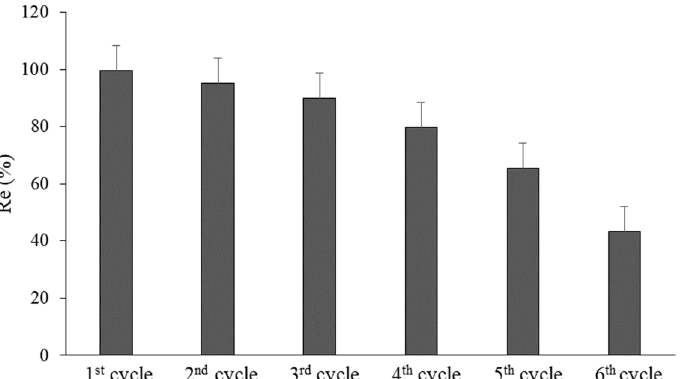
Figure 14. Pb(II) removal efficiency by nZVFe–RSAC after six consecutive cycles